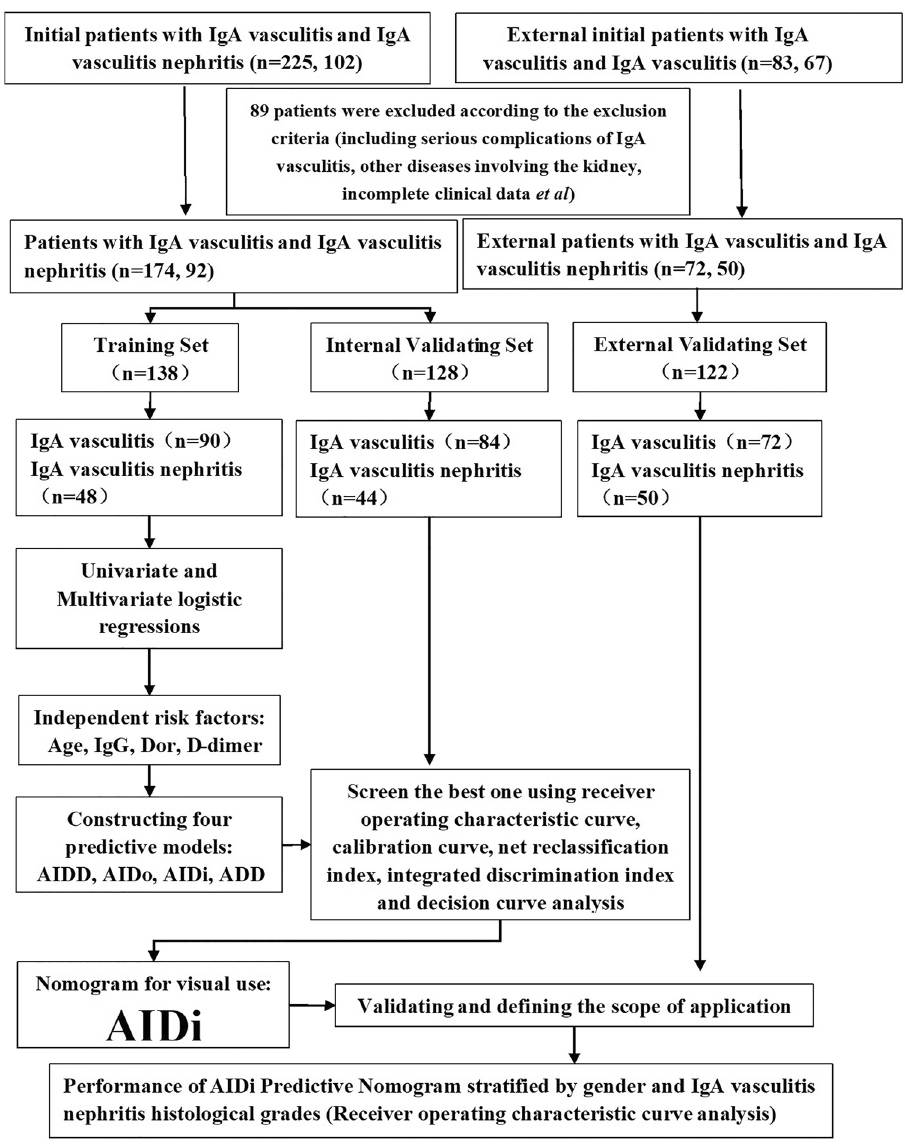
Figure 5. Flow chart of patients’ enrollment, grouping and the study